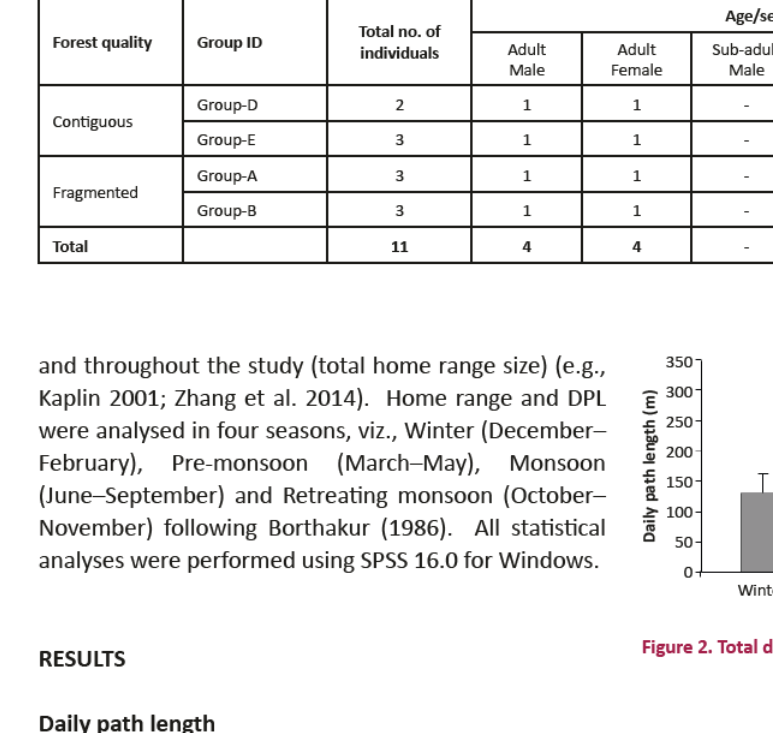
Table 2. Mean off daffily patth lengtth (DPL) wffitth mffinffimum and maxffimum values off ffour sttudy groups ffin ffragmentted and conffiguous